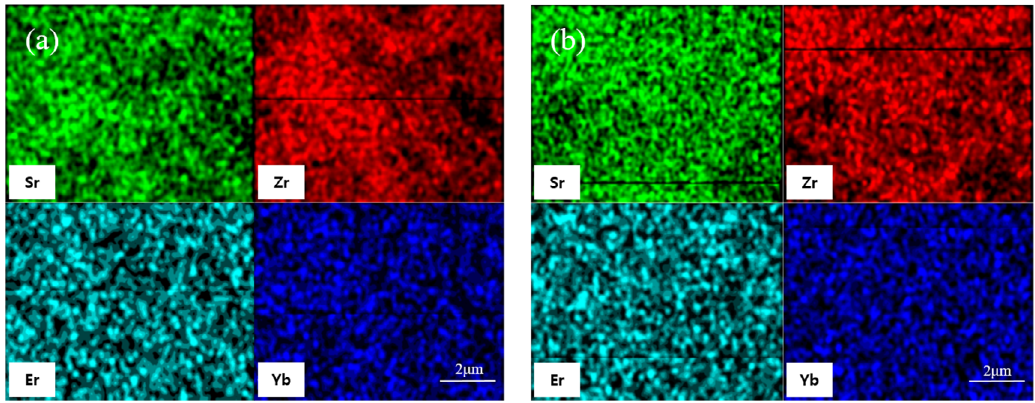
Fig. 3 Energy-dispersive X-ray spectroscopy mapping of x = 0.01 NCs annealed at (a) 1000 ℃ and (b) 1200 ℃ .